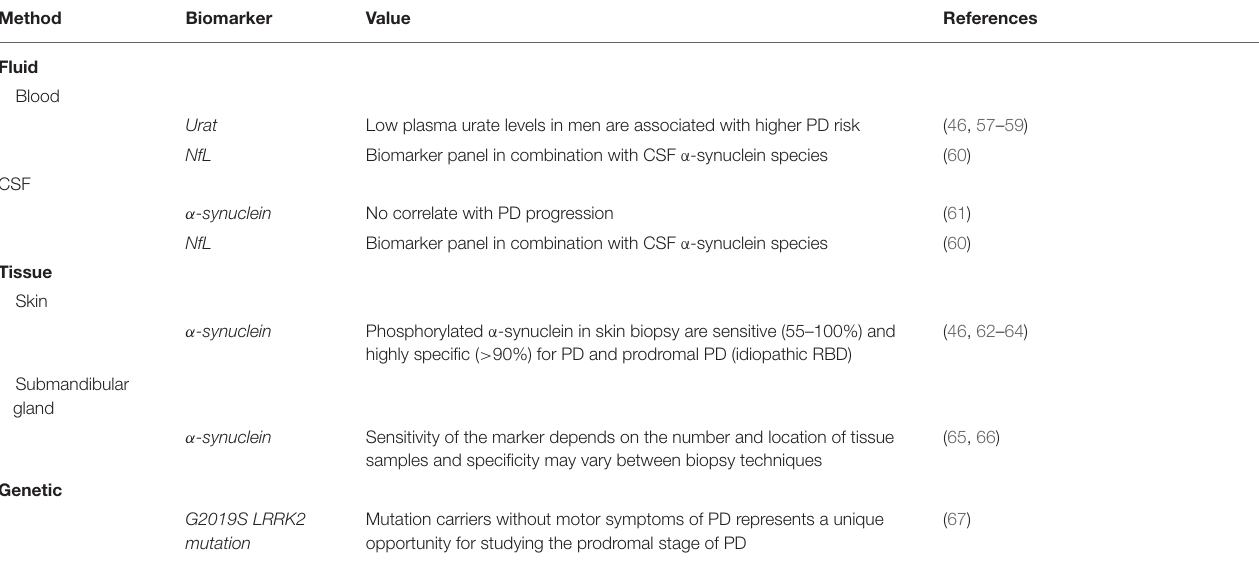
TABLE 2 | Fluid, tissue, and genetic markers of prodromal Parkinson’s